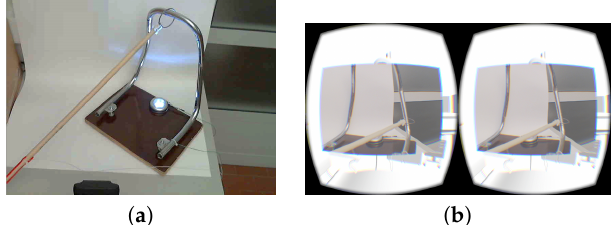
Figure 5. Task 3 setup: The user follows a predefined 3D path holding a stick with a metal loop through a thick metallic pipe avoiding contact. An LED light signals the electric contact. ( a ) Traditional interface vs. ( b ) immersive